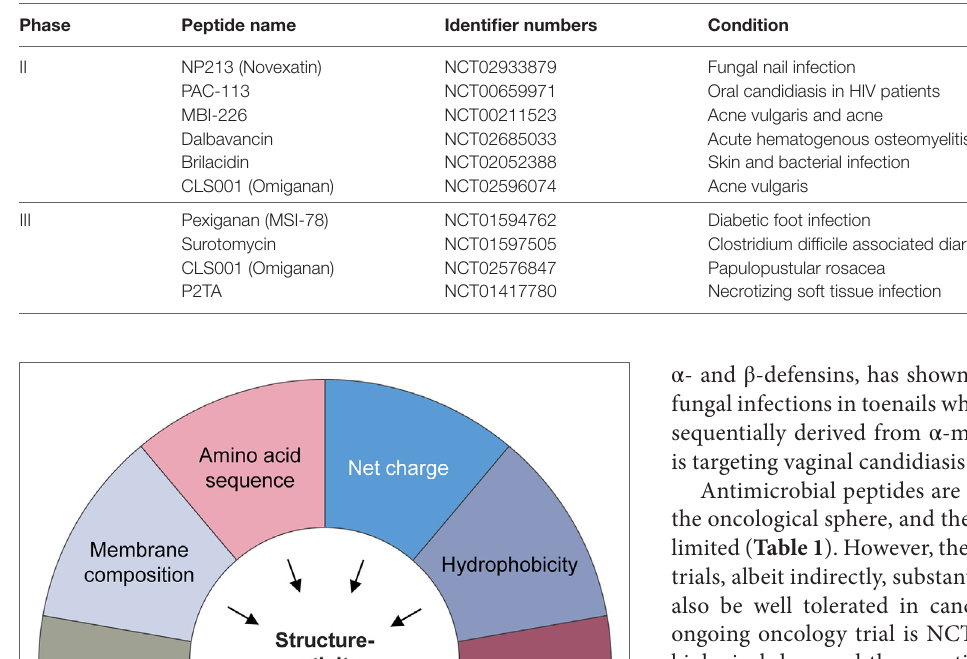
TABLe 2 | Antimicrobial peptides for infectious diseases indications in ongoing clinical